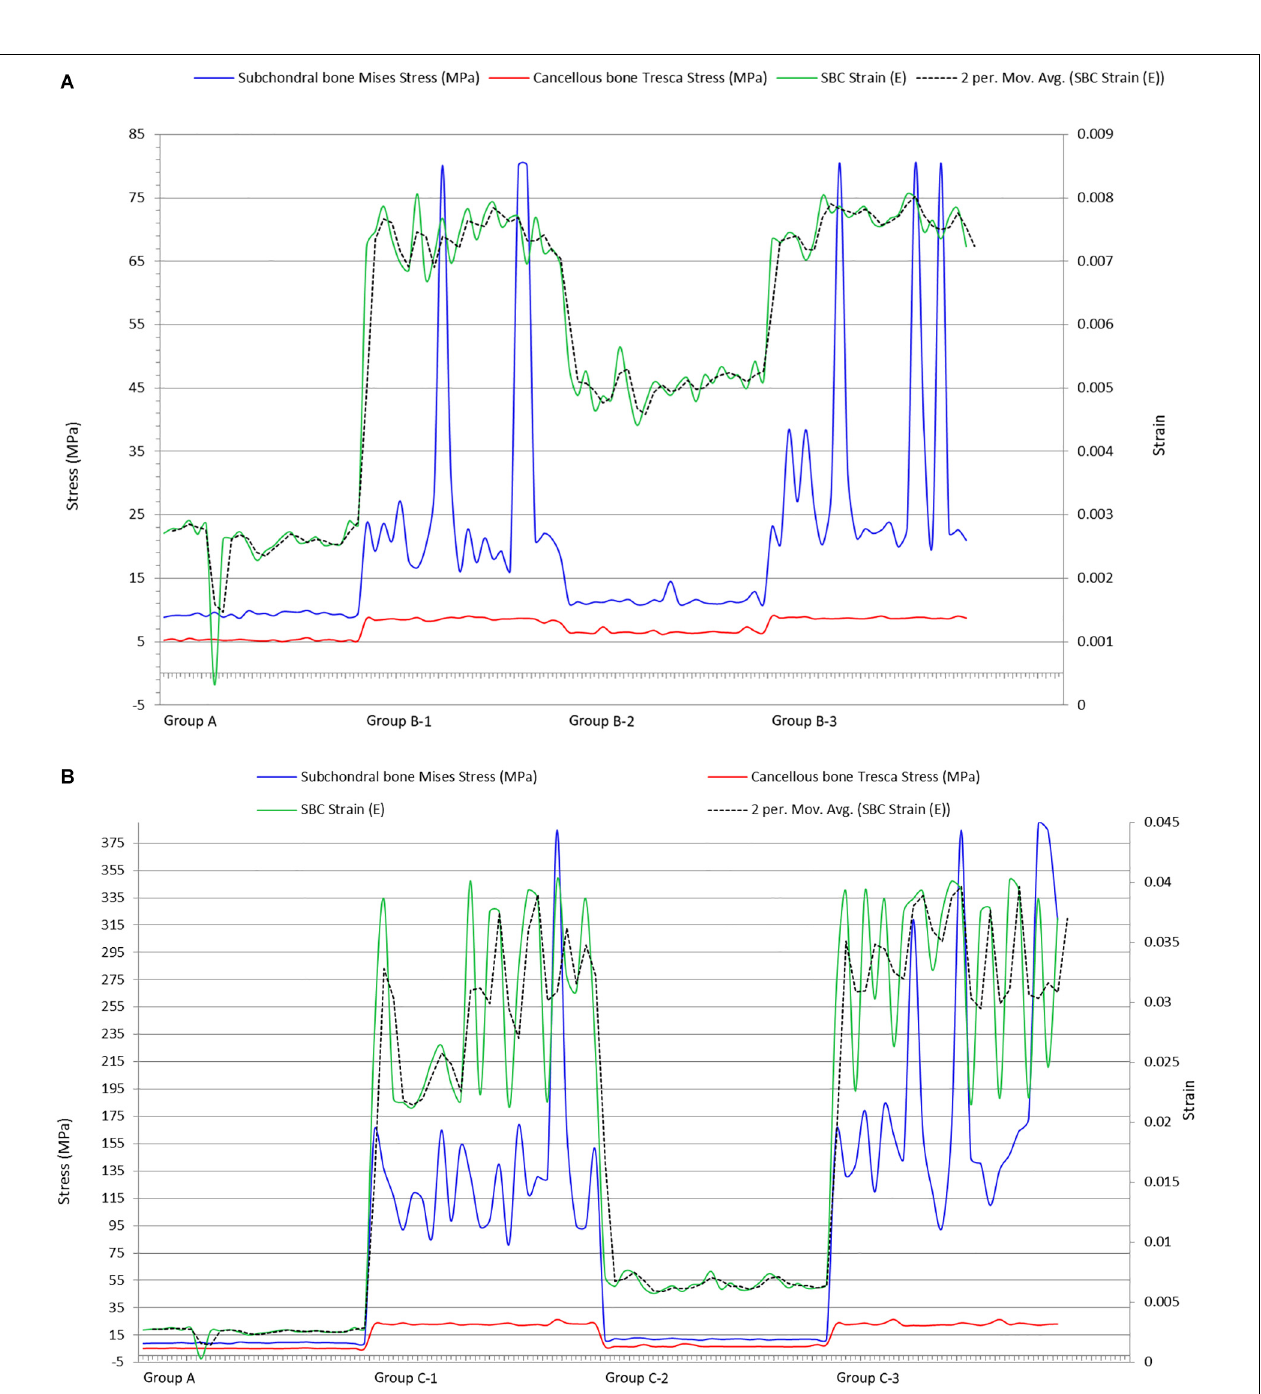
FIGURE 8 | Plots showing impact of SBCs strain on subchondral and cancellous bones in (A) group B and (B) group C. SBCs, subchondral bone cysts.